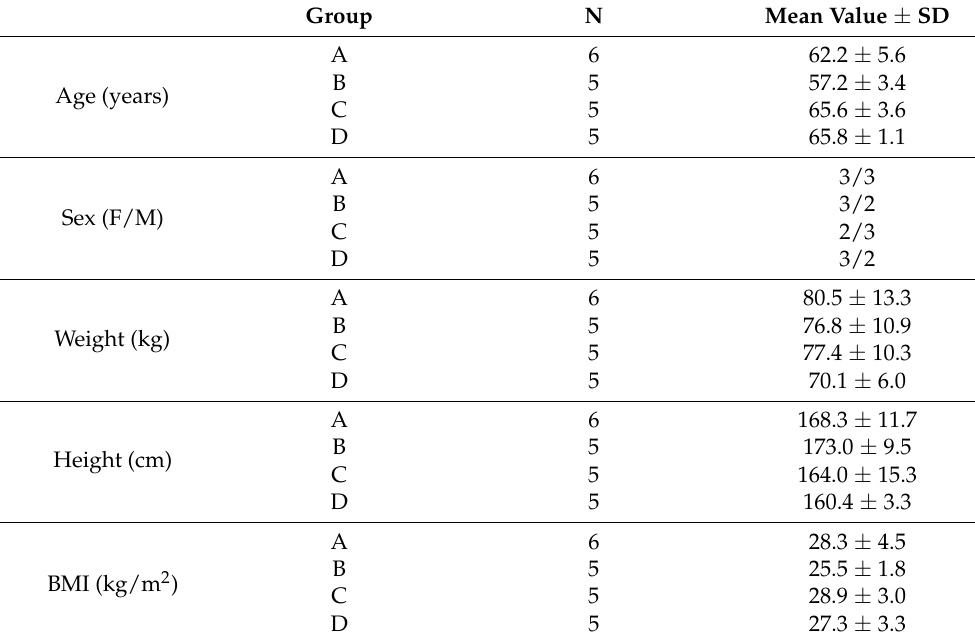
Table 2. Anthropometric characteristics of the study population under study divided according to treatment group. Abbreviations: BMI, body mass index, F, female; M,